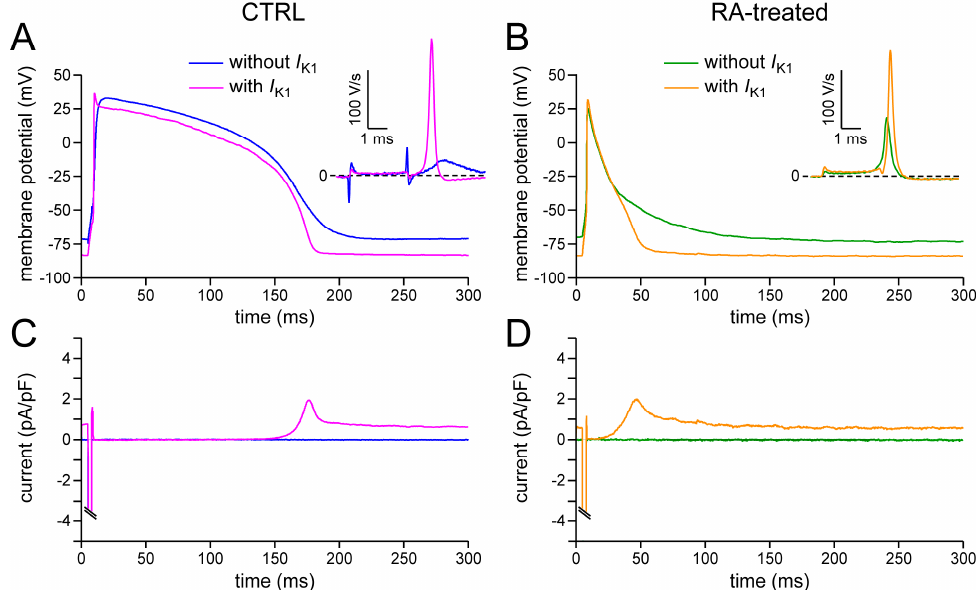
Figure 3. Effect of I K1 injection on the action potential of hiPSC-CMs. ( A , B ) Action potential of ( A ) a CTRL and ( B ) an RA-treated hiPSC-CM in the absence and presence of a synthetic I K1 , which is computed in real time according to the current–voltage relationship of Figure 2B and supplied through the patch-camp pipette. Insets: time derivative of the AP upstroke. ( C , D ) Corresponding dynamic clamp current injected into the cell. The sharp cut-off peak of 3 ms duration starting at 5 ms represents the stimulus current, which is applied at 1 Hz.